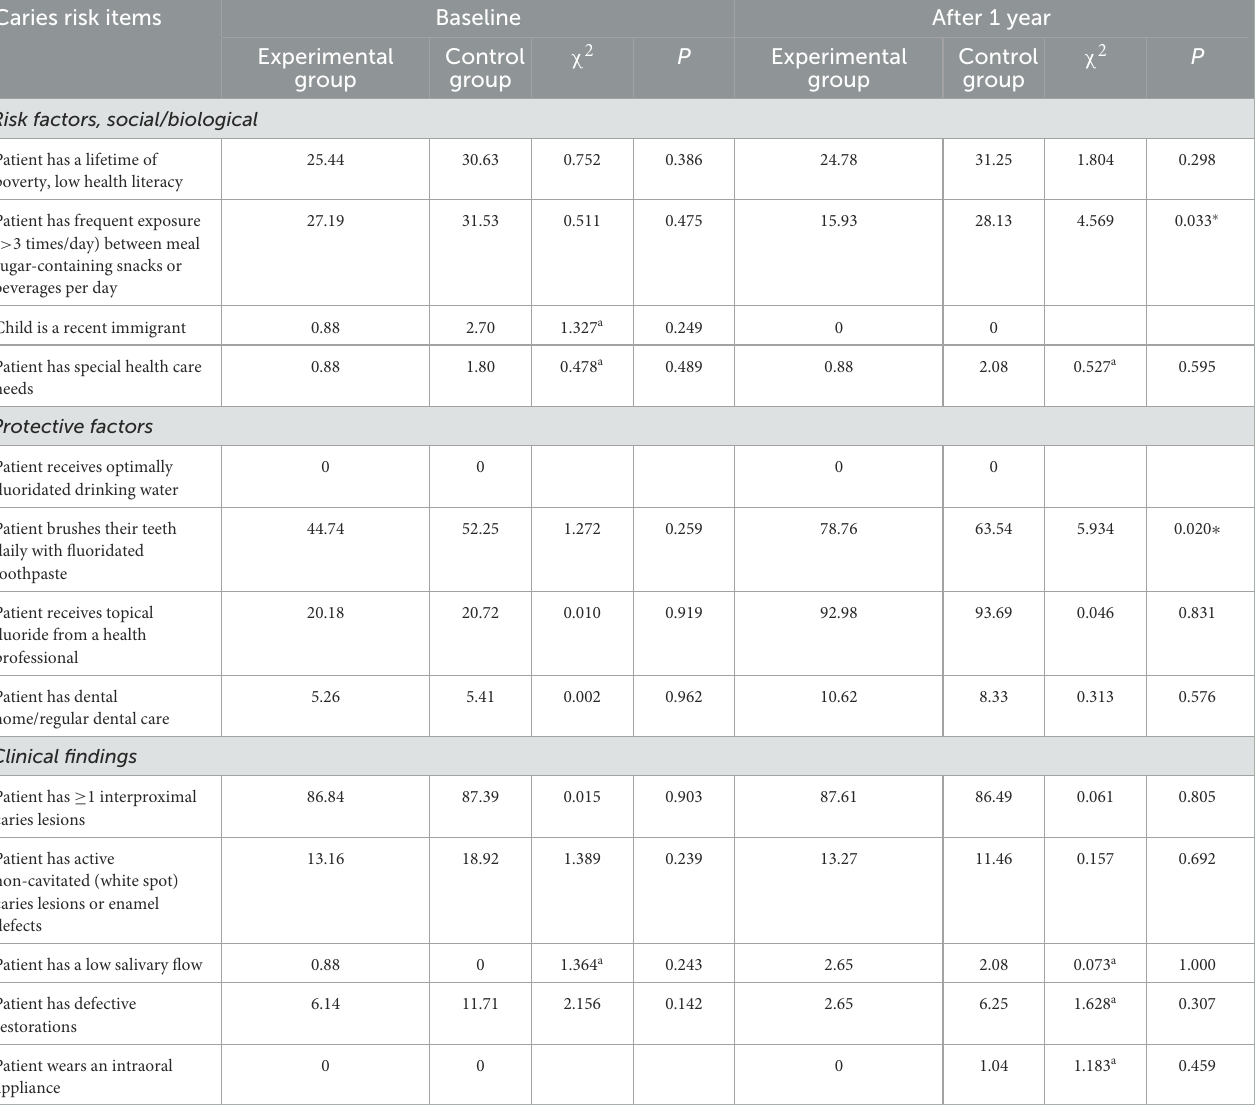
TABLE 2 Caries risk assessment items in two groups before and after a year (%). Caries risk items